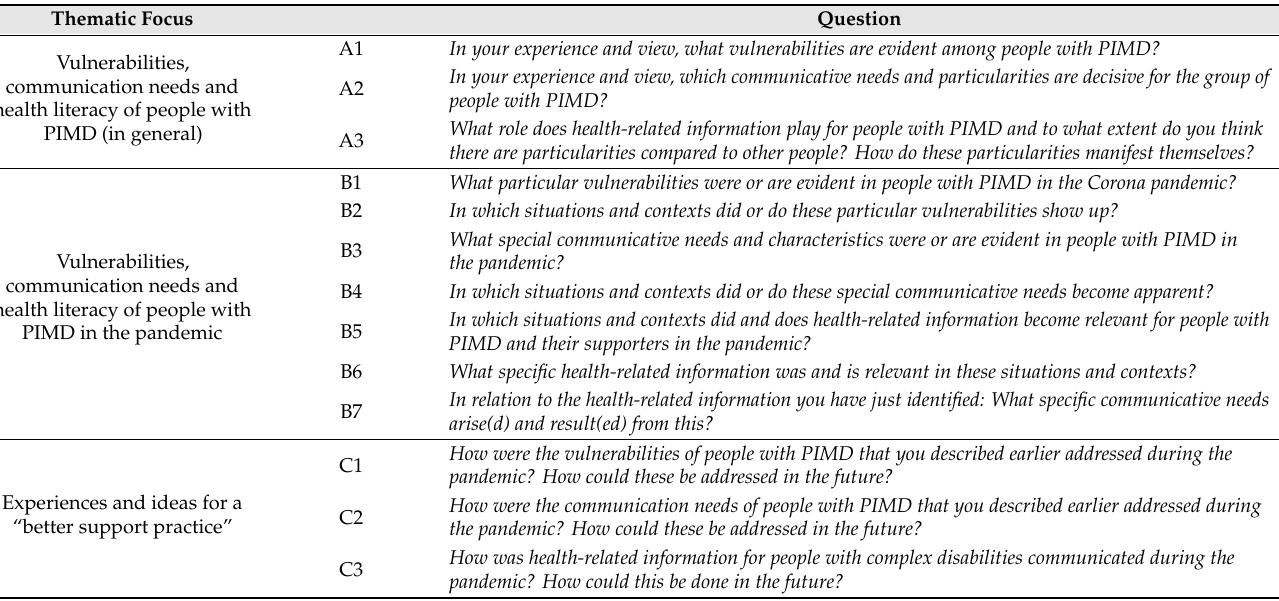
Table A1. Questionnaire for the first round of the Delphi study (“Delphi-1”; time frame for